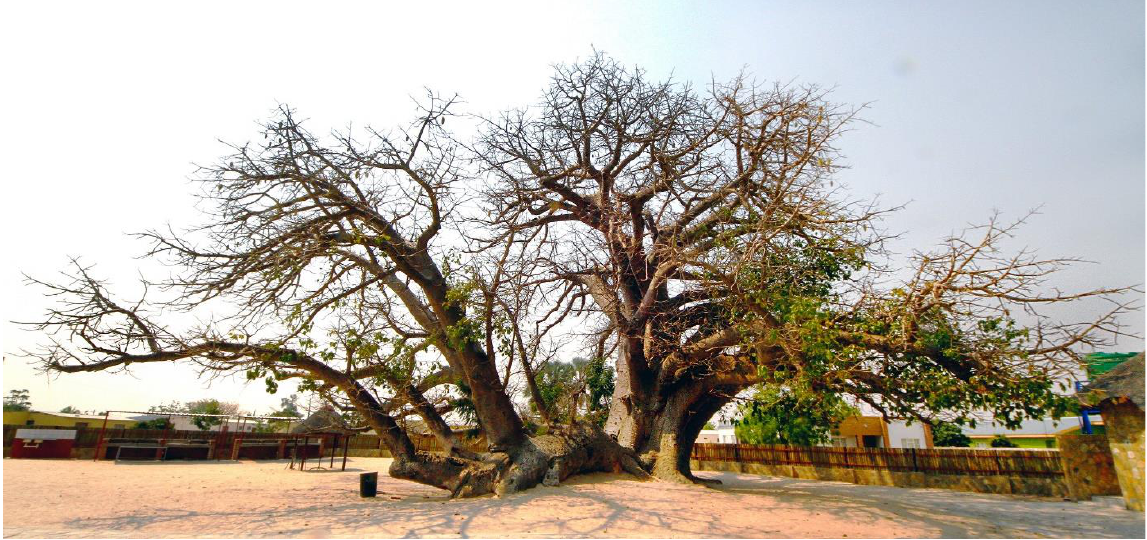
Figure 5. General view of the partially collapsed Okahao baobab inside the Okahao Baobab National Heritage Site (opened in 2013).